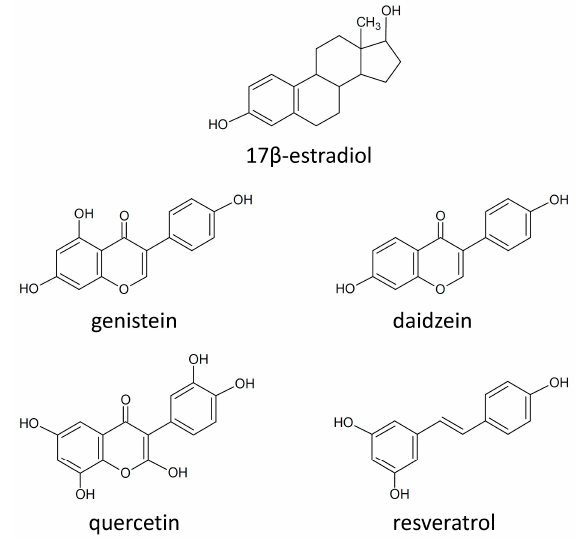
Figure 5. Chemical structure of 17 β -estradiol and phytoestrogens [134,138].